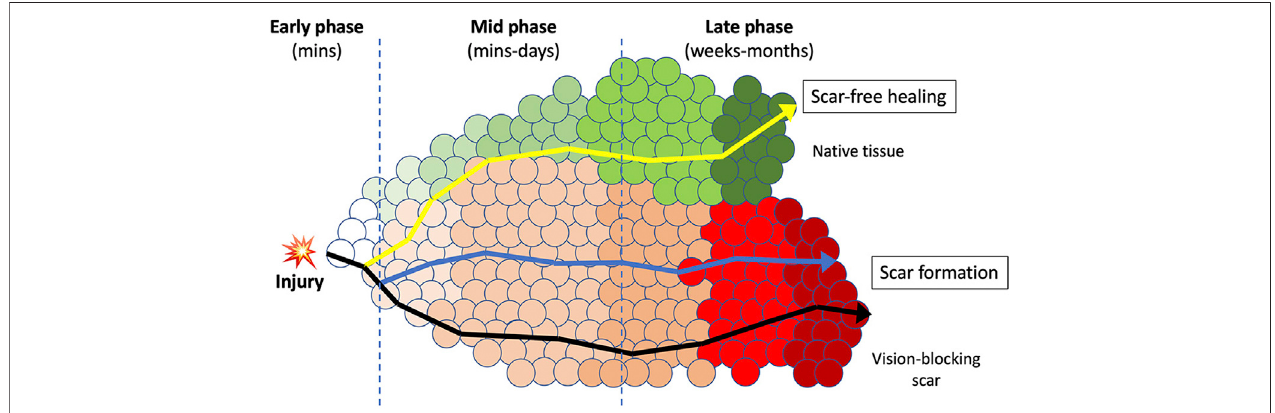
FIGURE 1 | A schematic diagram illustrating the early intervention therapy to re-route the wound healing and scarring response. A continuous spectrum of micro- niches (circles) that represent molecular and phenotypic events that constantly changes over time after injury. The route passes through these processes and the fi nal phenotypic outcome is dependent upon the micro-niches in which resident and in fi ltrating cells are interacting with the extracellular regions. In adult tissue, upon injury, the normal transition through these sequential micro-niches usually ends up in scar formation (dark line). In corneas, this will block the light passage and results in vision loss. Medications modulating minor pathways could alter the micro-niches, but still results in similar phenotypic outcome of scar formation (blue line). Intervention at early time after wounding could alter the wound microenvironment and produce a “ re-routing ” through a different series of processes that could result in scar improvement or scar-free healing, and regeneration of native tissues (yellow line). This can improve the corneal clarity and restore vision.